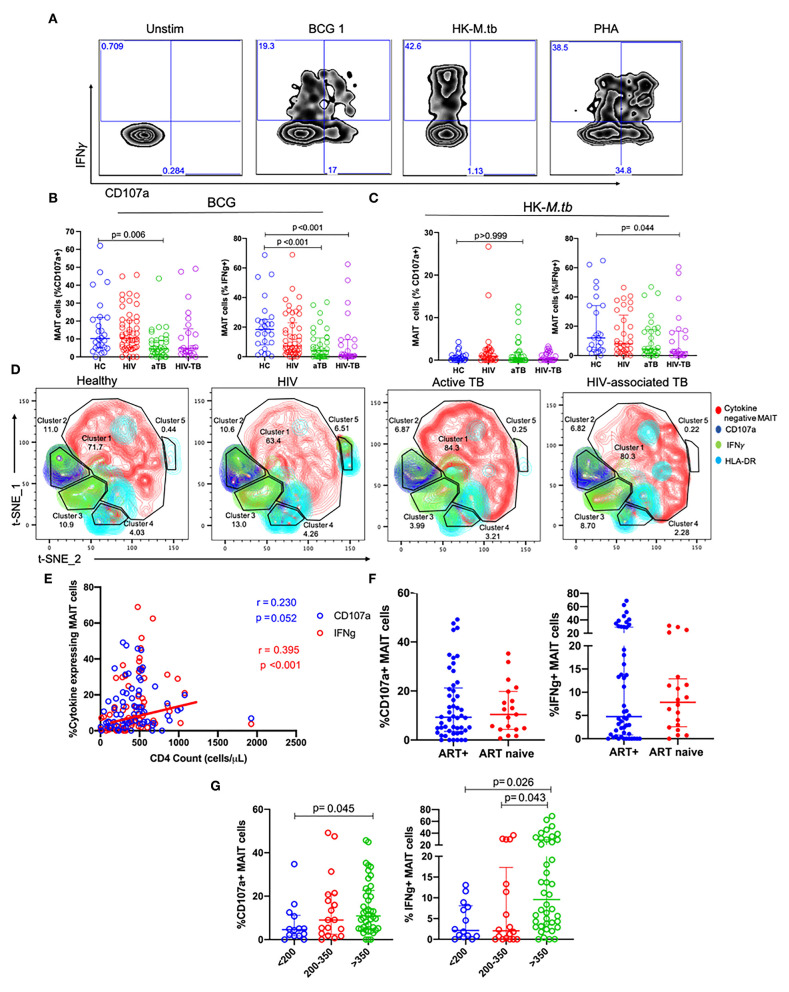
MAIT cell responses after BCG and HK-M.tb stimulation. (A) Representative plots showing IFNγ and CD107a expression after stimulation with BCG 1, heat-killed M.tb (HK-M.tb), and phytohemagglutinin (PHA). (B,C) Expression of CD107a and IFNγ after BCG stimulation and HK-M.tb stimulation, respectively. (D) Contour plots for t-SNE analysis of MAIT cell functions between the different groups. red-cytokine-MAIT cells; dark-blue-CD107a+ MAIT cells; green-IFNg+ MAIT cells; light blue-HLA-DR+ MAIT cells. (E) CD4 counts of HIV and HIV-TB group participants and frequencies of MAIT cells expressing CD107a and IFNγ, assessed using Spearman correlation. (F) Effect of ART on MAIT cells expressing CD107a and IFNγ. (G) Effect of CD4 counts on MAIT cells expressing CD107a and IFNγ. P-values reported from Kruskal-Wallis test with a Dunn's post-hoc test for multiple comparisons and p < 0.05 reported as statistically significant. HC, Healthy controls group; HIV, HIV only group; aTB, active TB only group; HIV-TB, HIV-associated TB group.